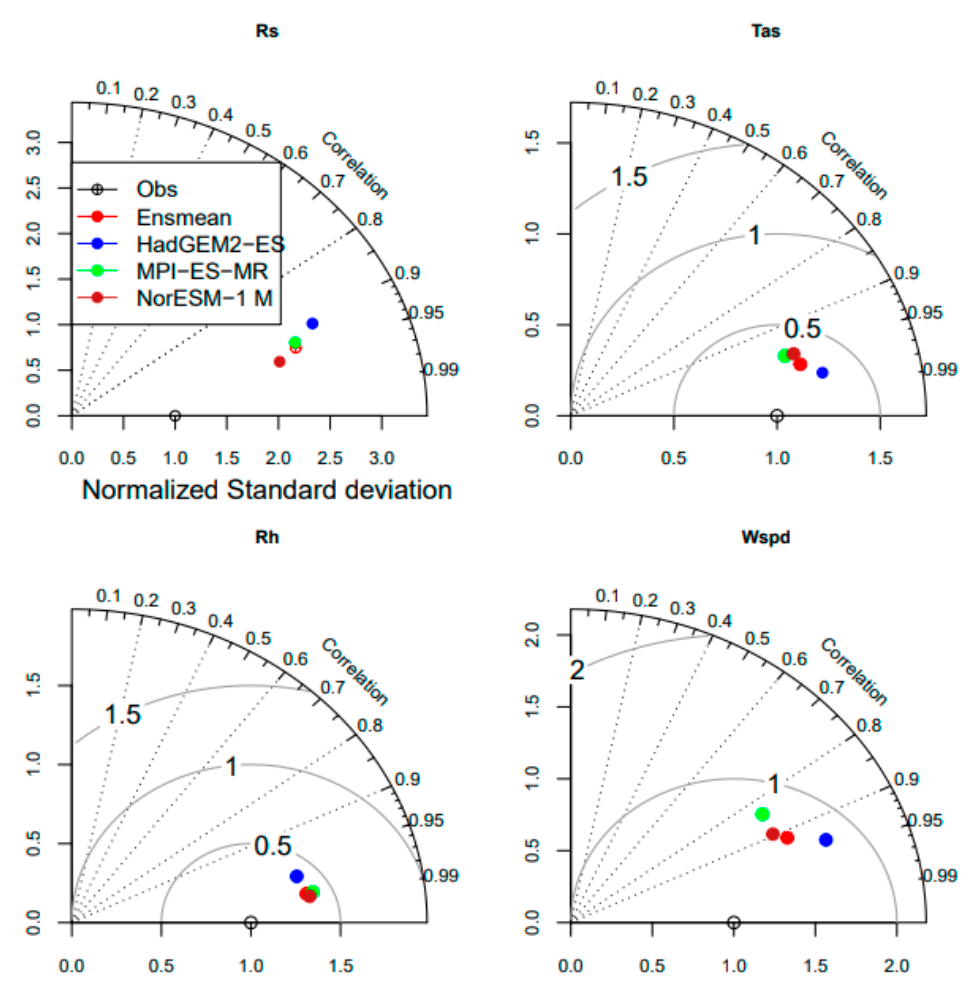
Figure 3. Taylor diagrams comparing the statistics (spatial correlation and normalized standard deviation) of Rs, Tas, Rh, and Wspd as simulated by RegCM4 and observation .